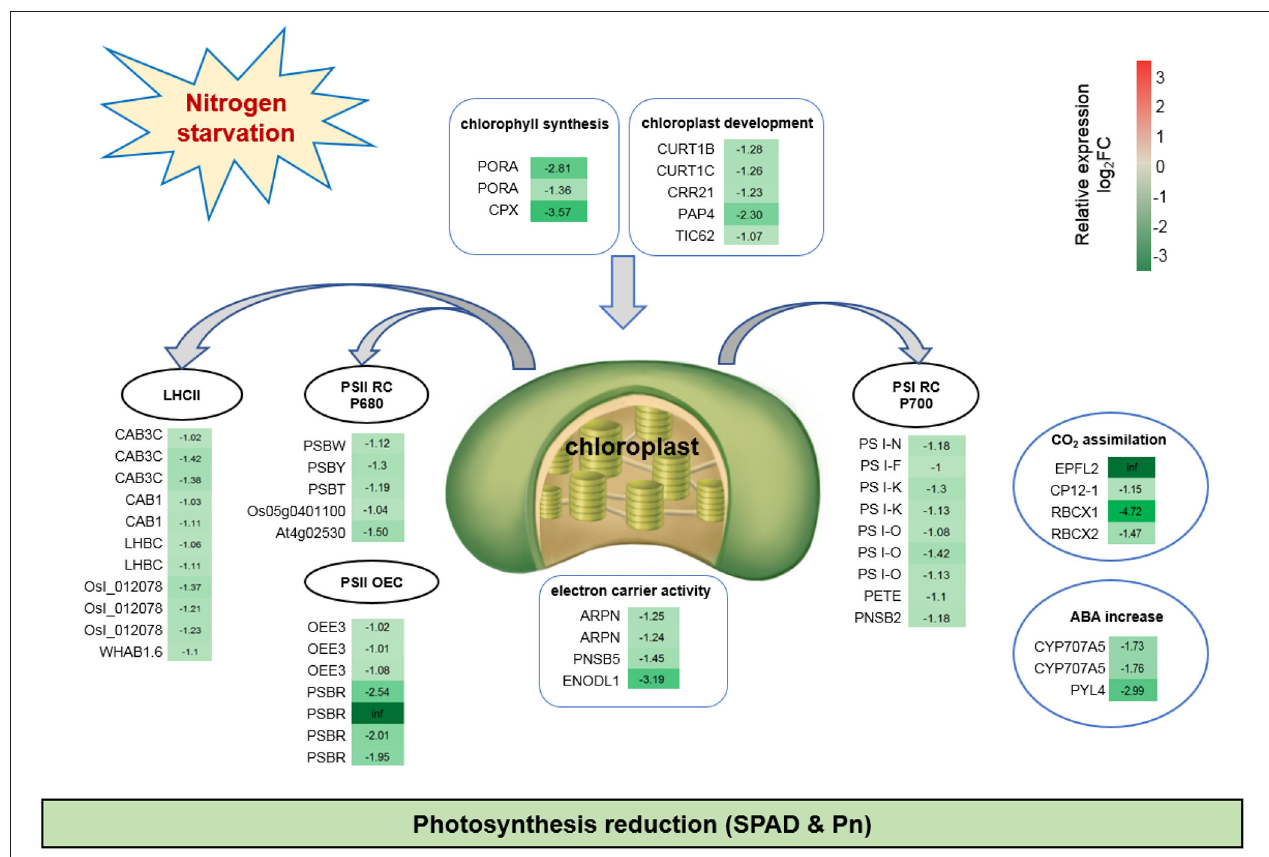
FIGURE 5 | Fifty-one down-regulated DEGs suggesting inhibited photosynthesis under N starvation conditions. The relative expression levels as described by log 2 FC (FC is the fold change of RPKM means N0/Nck) are represented by a color gradient from low (green) to high (red). Under N-starvation conditions, the DEGs with log 2 FC > 0 represent up-regulated expression, log 2 FC < 0 represents down-regulated expression, and log 2 FC = 0 represents unchanged